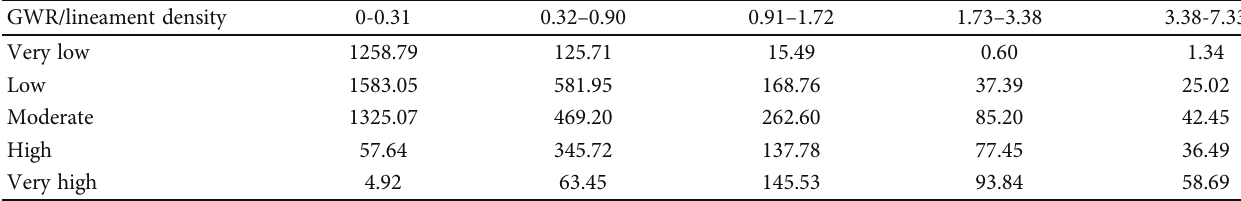
Table 16: Cross-tabulation between GWR and lineament density.